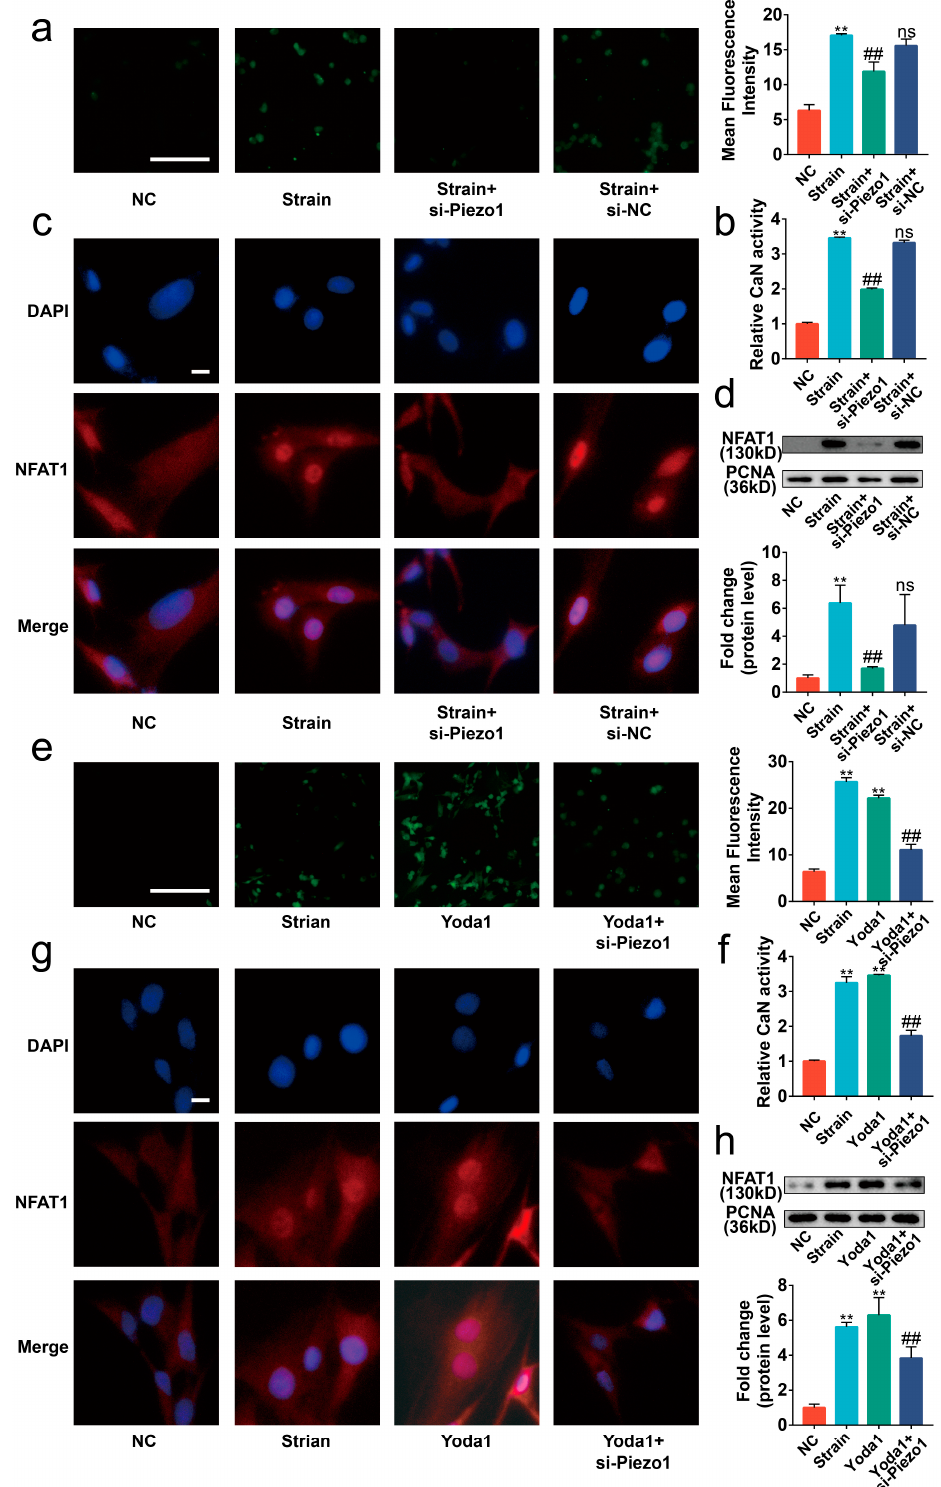
Figure 4. Piezo1 activated the CaN/NFAT1 signaling axis under mechanical strain. ( a , e ) Representa- tive image of the Flou-4 AM stain ( n = 3), scale bar: 100 μ m. ( b , f ) The activity of CaN is determined by the CaN Activity Kit ( n = 3). ( c , g ) Representative immunofluorescence image of NFAT1 nuclear translocation in each group ( n = 3), scale bar: 10 μ m. ( d , h ) Western blot analysis of NFAT1 in chon- drocyte nucleoprotein ( n = 3). ** p < 0.01 vs. NC; ## p < 0.01 vs. strain or Yoda1; ns, no significant differences. One-way ANOVA with Bonferroni’s test for ( a,b,d – f,h ).